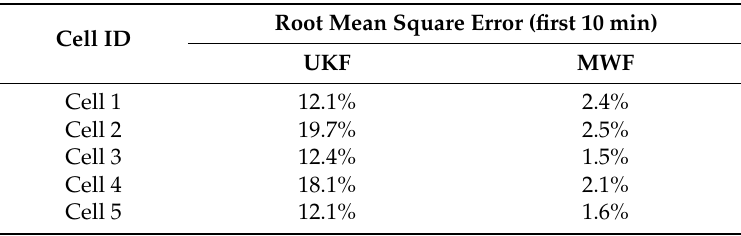
Table 3. Summary of SOC estimation results based on electrochemical model and